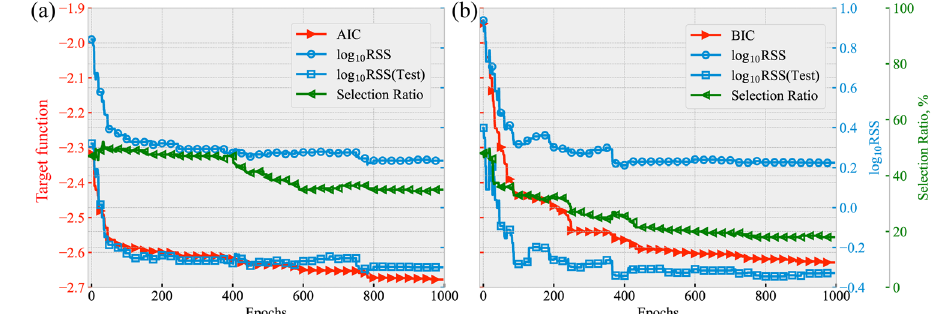
Fig. 3 Convergence sequences of the joint parameter selection and estimation processes. Results for joint parameter selection and estimation using variable-selection genetic algorithm based on a AIC and b